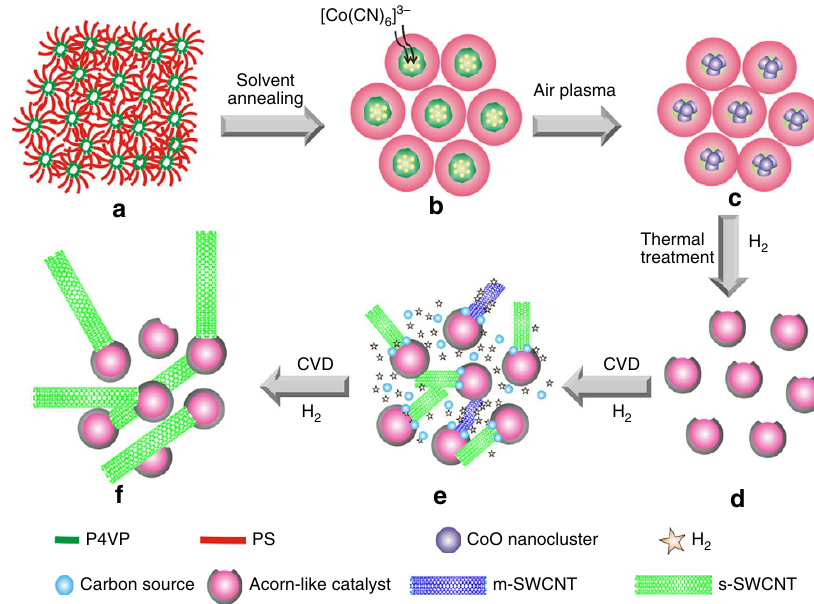
Figure 1 | Schematic showing the formation of carbon-coated Co nanoparticles and the growth of s-SWCNTs. ( a ) A self-assembled PS-b-P4VP film. ( b ) Formation of phase-separated nanodomains and adsorption of [Co(CN) 6 ] 3 (cid:2) catalyst precursors. ( c ) CoO nanoclusters partially surrounded by residual polymer. ( d ) Co nanoparticles partially coated with carbon. ( e ) Nucleation and growth of SWCNTs with a narrow diameter distribution grown from the partially carbon-coated Co nanoparticles and in situ etching of m-SWCNTs. ( f ) s-SWCNTs with a narrow band-gap